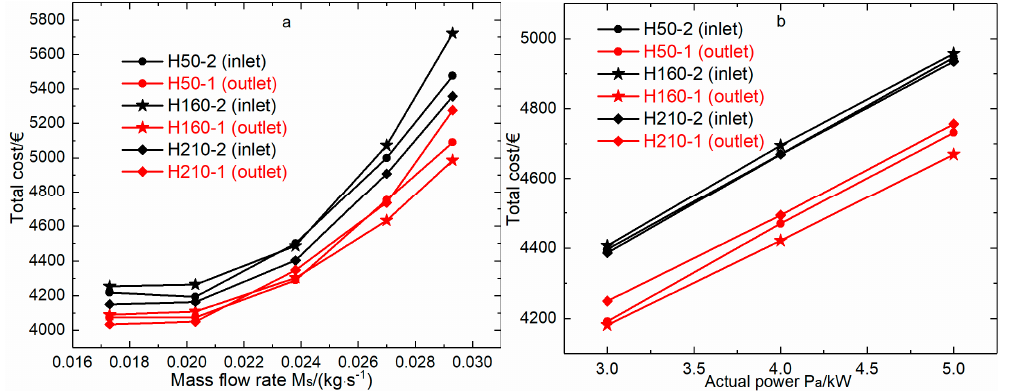
Figure 11. ( a ) comprehensive performance index K / ∆ P 1 3 versus mass flow rate ( b ) comprehensive performance index j / f 1 3 versus mass flow rate.